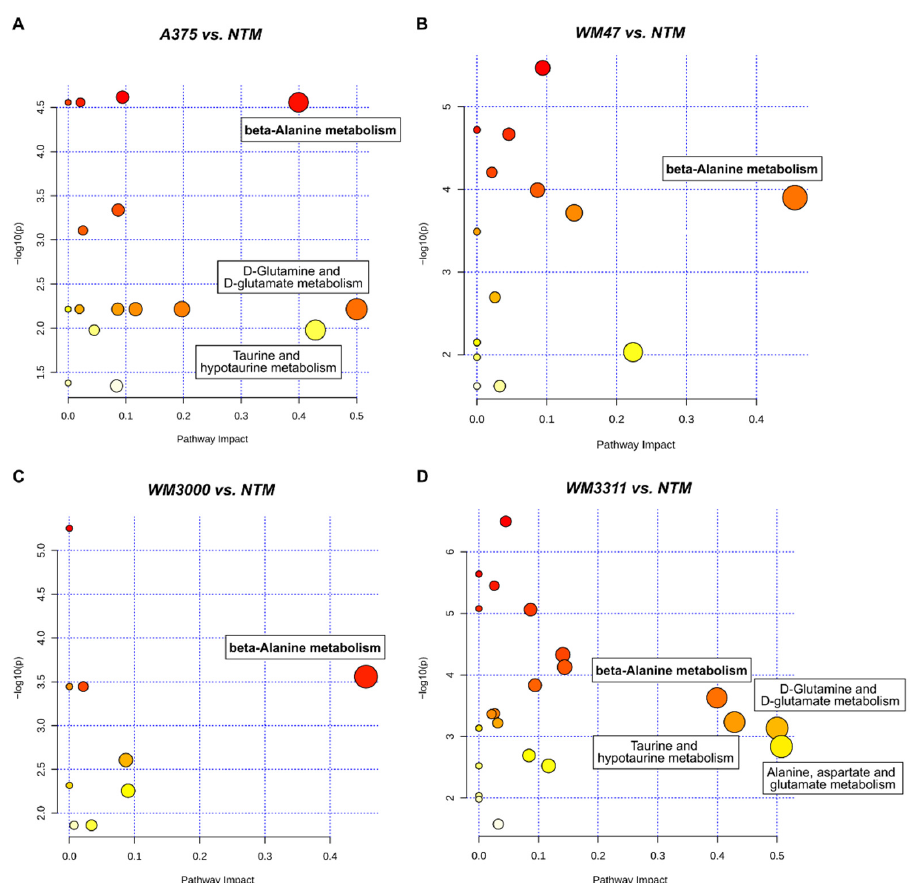
(Figure 6A,D). In plasma of WM3311 versus NTM, alanine, aspartate and glutamate metabolism was additionally ranked with a significant p-value and the highest impact score (Figure 6D) (Supplementary File 3).